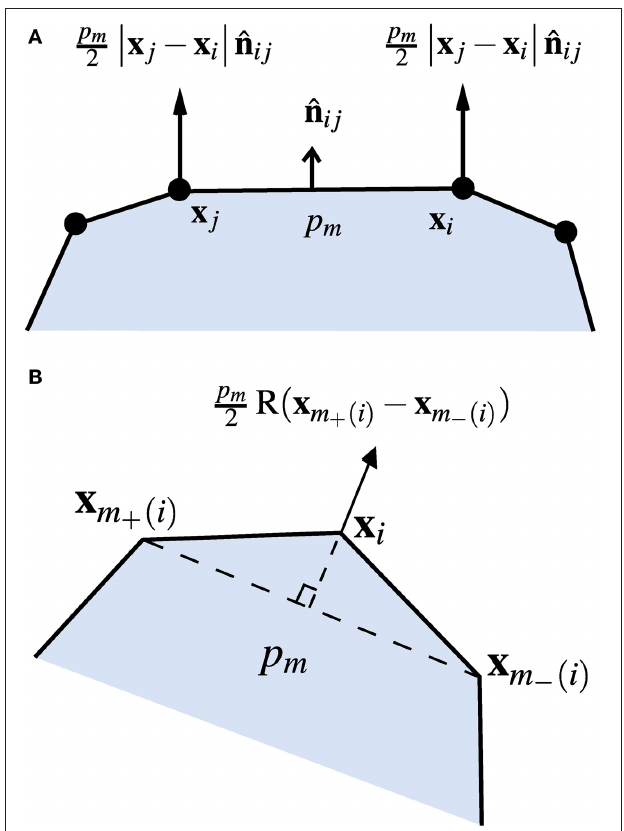
FIGURE 2 | Turgor pressure forces. (A) Forces from the pressure p m in cell m acting on the wall between vertices x i and x j . (B) Total force acting on the vertex x i from the pressure in cell m